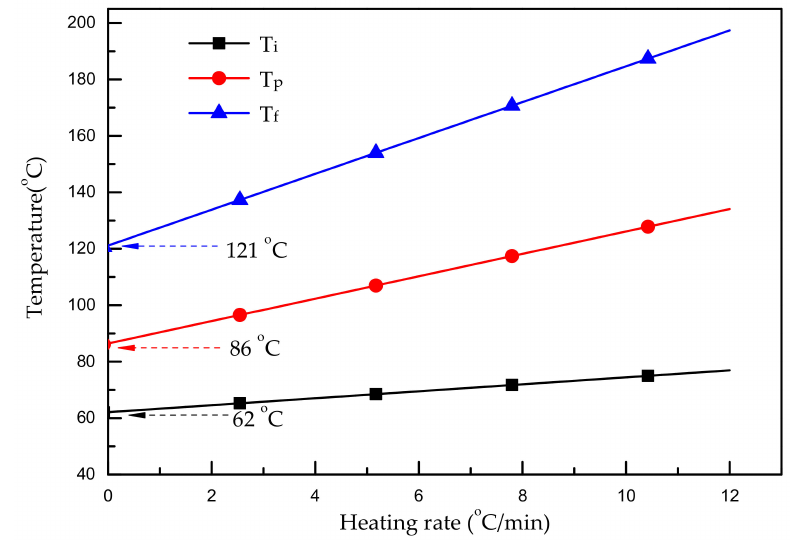
Figure 3. Extrapolation method to determine curing temperature of the resin